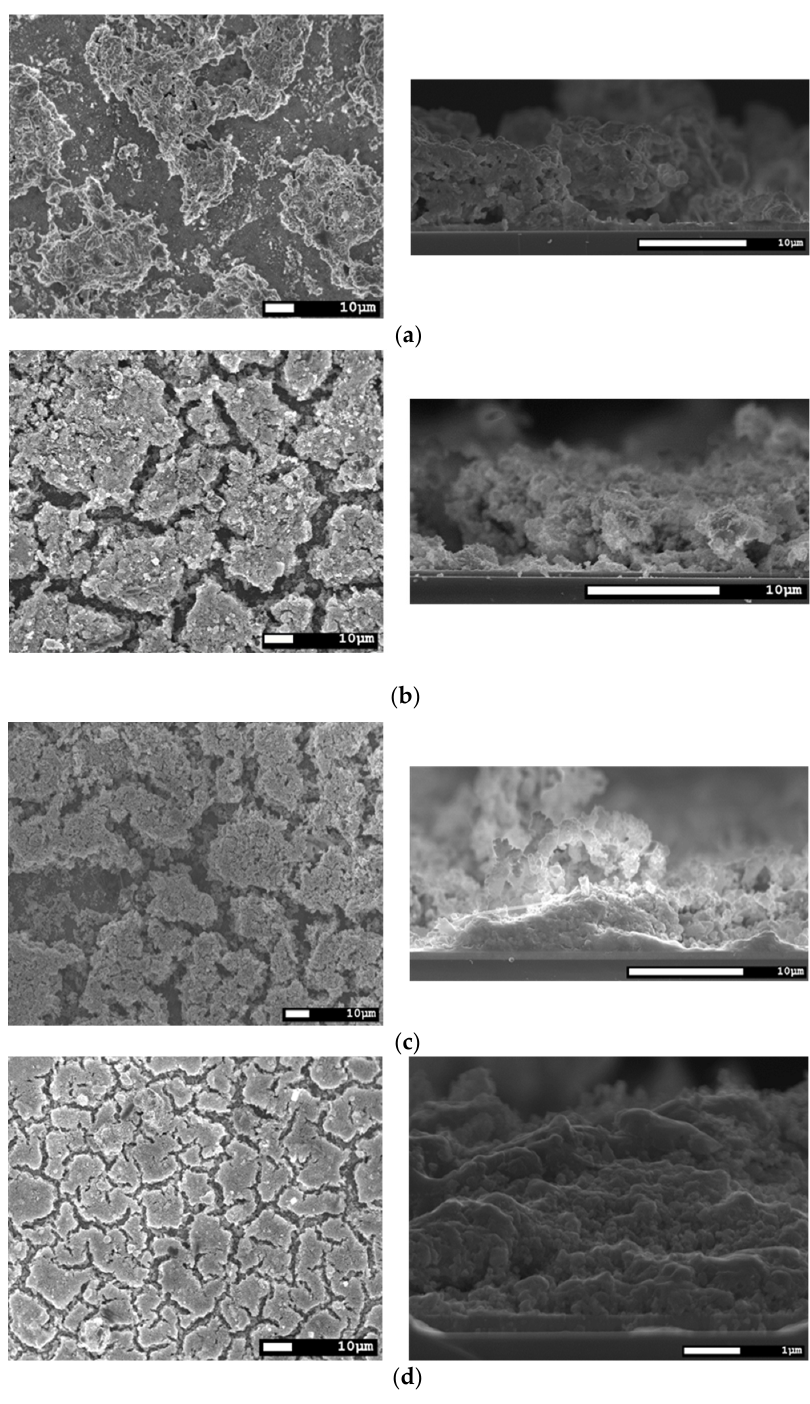
Figure 7. SEM top view and cross‐section of a CISe‐film from Cu 2− x Se + In 2 Se 3 nanoparticle precursor after different temperature treatments. ( a ) Face‐to‐face annealing at 550 °C for 5 min with 46.1 kN/m² pressure. ( b ) Annealing in the tube furnace at 550 °C for 5 min without application of pressure. ( c ) Two times repetition of ink‐coating and face‐to‐face annealing at 550 °C for 5 min with 46.1 kN/m² pressure. ( d ) Using an ethanol based nano‐ink and annealing in the tube furnace at 550 °C for 5 min without application of pressure.